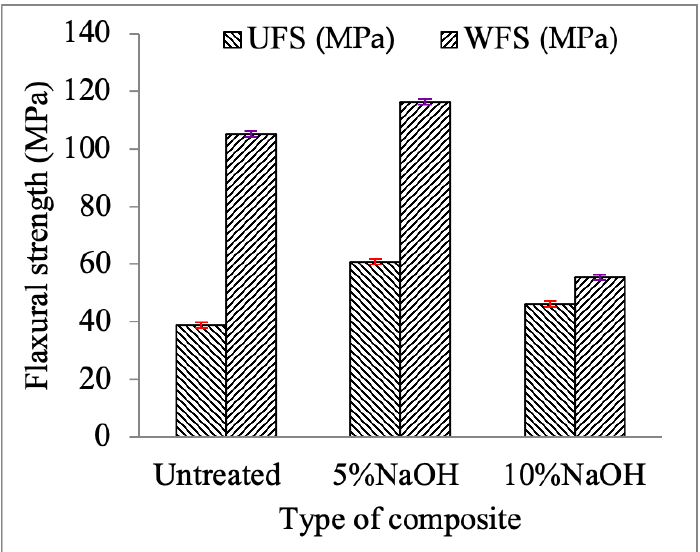
Figure 5. The flexural strength of unidirectional (UFS) and woven (WFS) composites.